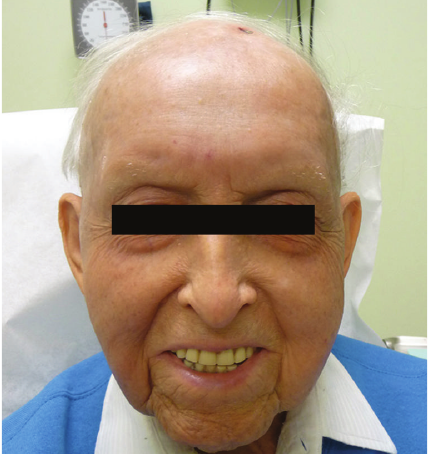
Figure 5: Presentation of the patient 1 month after treatment with radiation treatment as a single